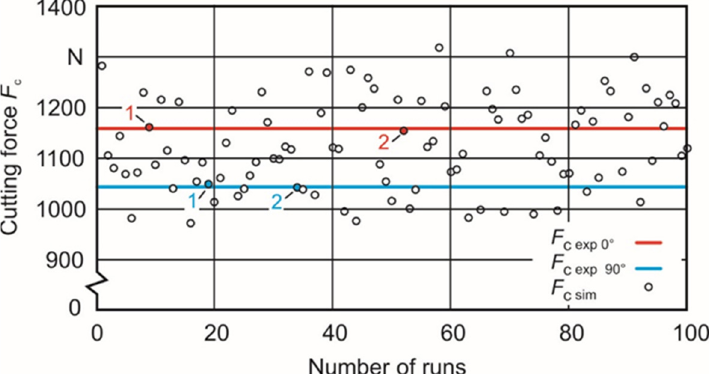
Figure 5. First iteration with 100 runs between the upper and lower limit and experimentally gained cutting forces for orientations φ = 0° and 90°.